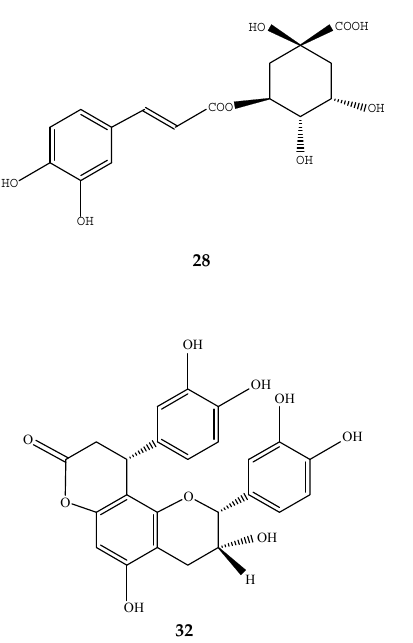
Figure 4. Structures of chemical compounds 28 – 33 . 28 : chlorogenic acid; 29 : quercetin-3-sambubioside; 30 : kaempferol-3-rhamnoside; 31 : quercetin-3-rhamnoside; 32 : cinchonain Ia; 33 : arbutin.